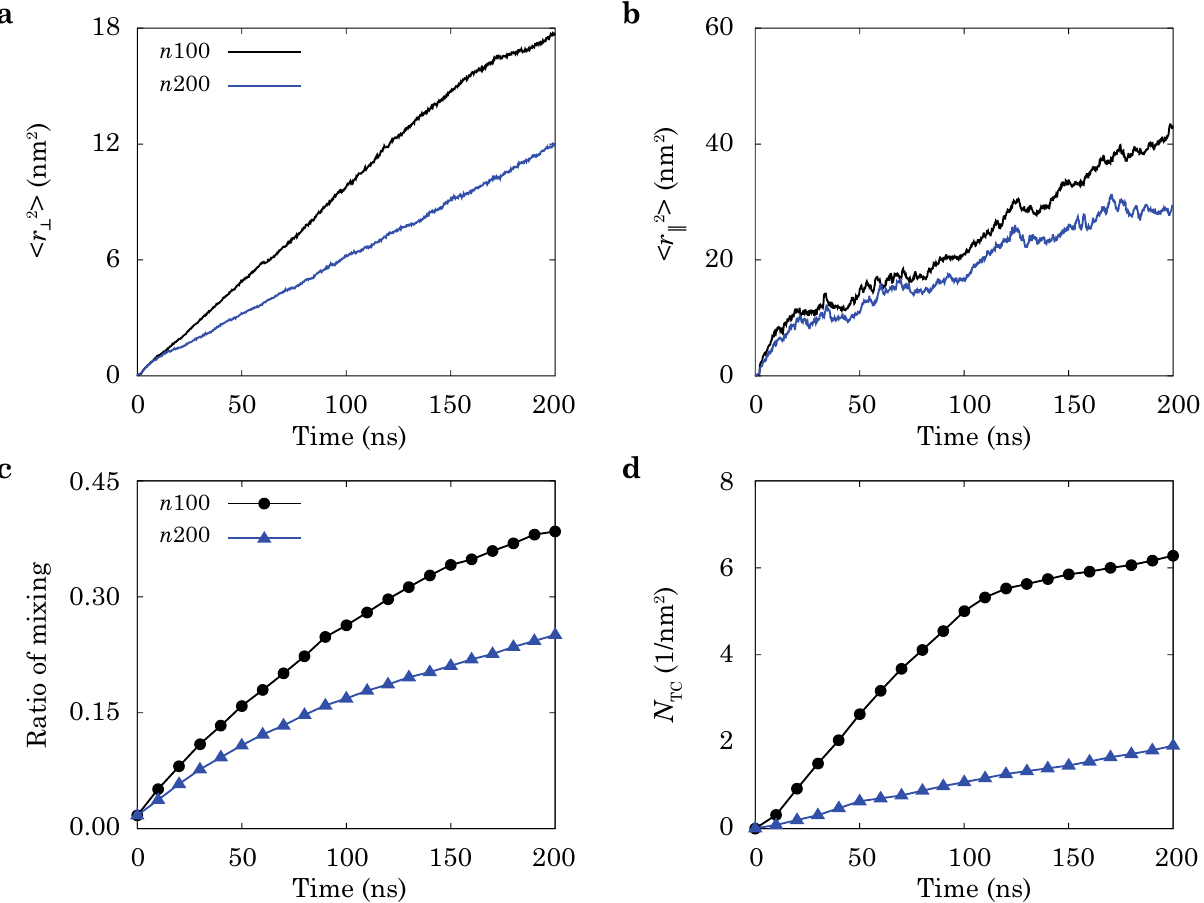
Figure 4. CGMD simulation results of the microstructural indicators measured for the PE/PP heat-fusion processes of polymer chains with different lengths, n 100 and n 200. ( a , b ) Mean-square distances (MSDs) 2 (cid:29) is the component parallel to the interface, and � r 2 of polymer chains across the interface, where (cid:31) r (cid:30) component normal to the interface. ( c ) Ratio of mixing and ( d ) areal density of TCs, N TC , are calculated against the time of fusion. The fusion conditions are 500 K and 1